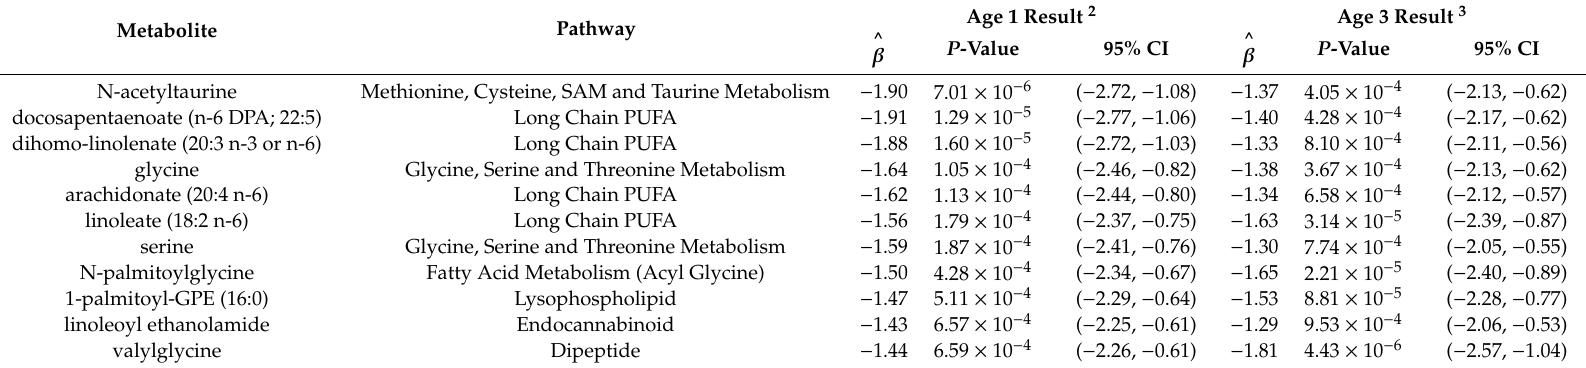
Table 4. Plasma metabolites significantly associated with 25(OH)D concentrations common to age 1 and 3 samples based on ENT80 thresholds 1 after excluding outliers in 25(OH)D distribution at respective time